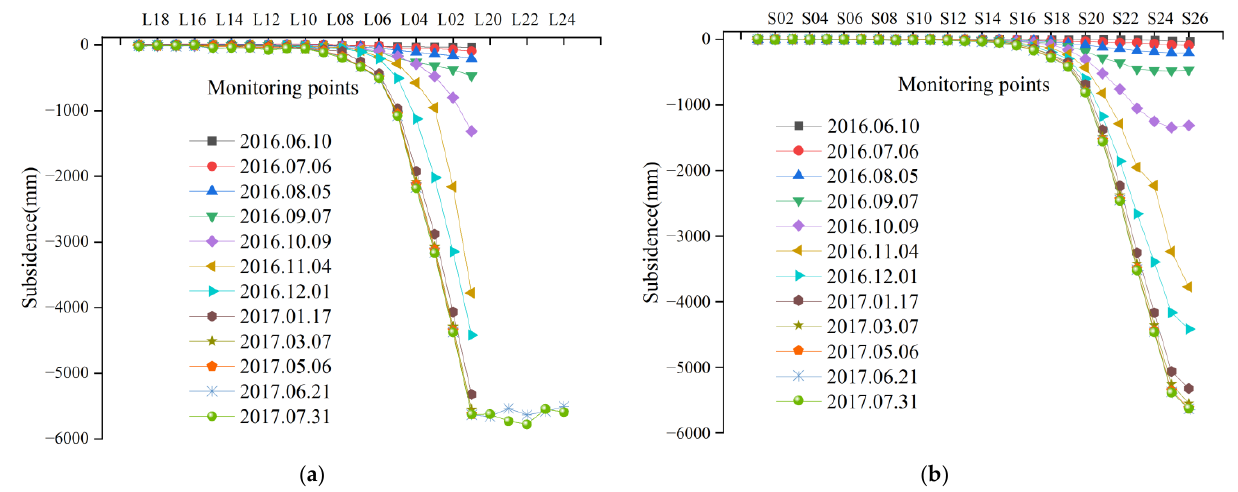
Figure 12. Measured subsidence value of main section of 11111 working face. ( a ) Measured values of strike main section. ( b ) Measured values of inclination main section.